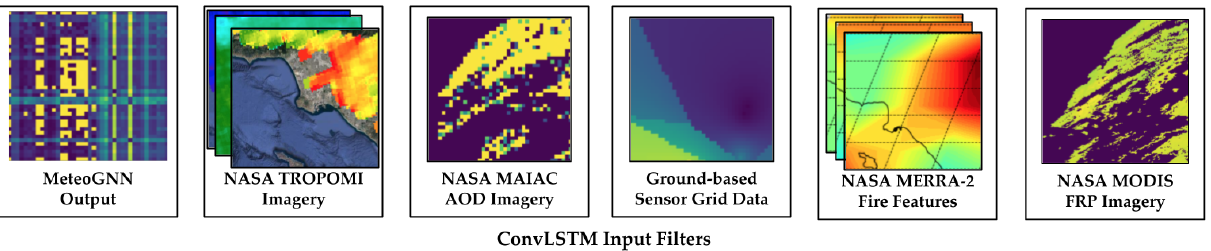
Figure 11. Visualization of input filters for our ConvLSTM